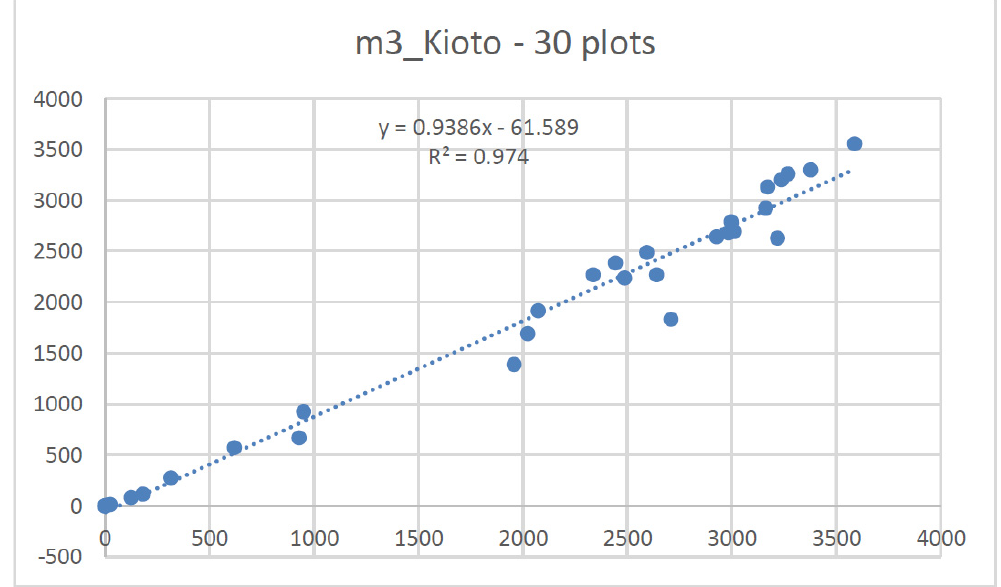
Figure A6. The reference area compared to the estimated forest area by Method 3 for test plots (30 × 30 m 2 ) according to the UNFCCC definition.